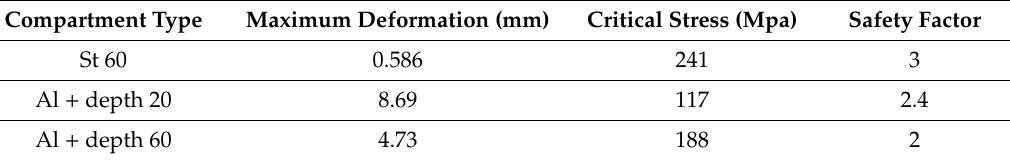
Table 5. Critical stress and deformation extracted from FE software.